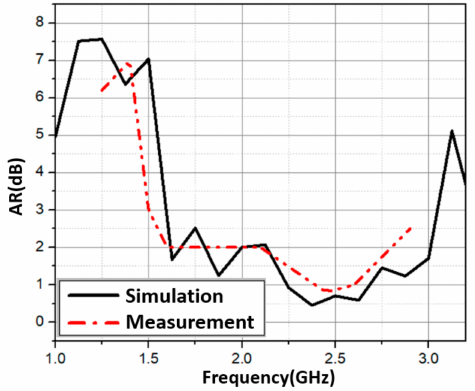
Figure 8. Simulated and measured axial ratio of the wideband and CP